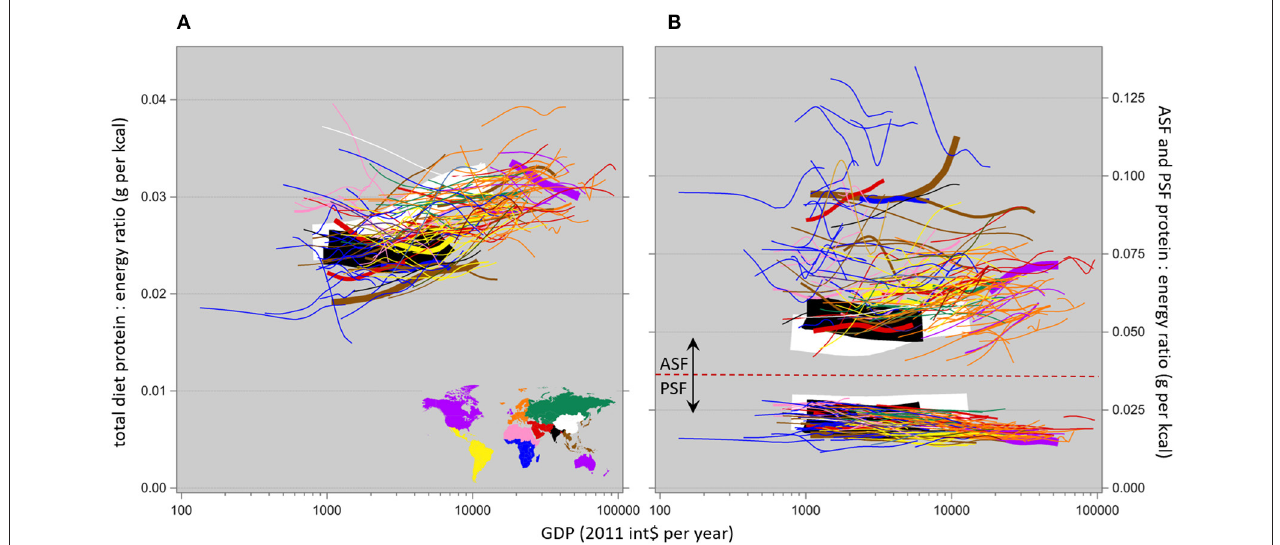
FIGURE 2 | Country-specific spline interpolation plots of the ratio of daily protein-to-energy consumption in relation to income, not adjusted for any non-income factors, in the total diet (A) and in the ASF- and PSF-based parts of the diet (B) . The width of each line reflects the country’s population size in 2016. Note that the x-axis is logarithmic and the y-axes differ in